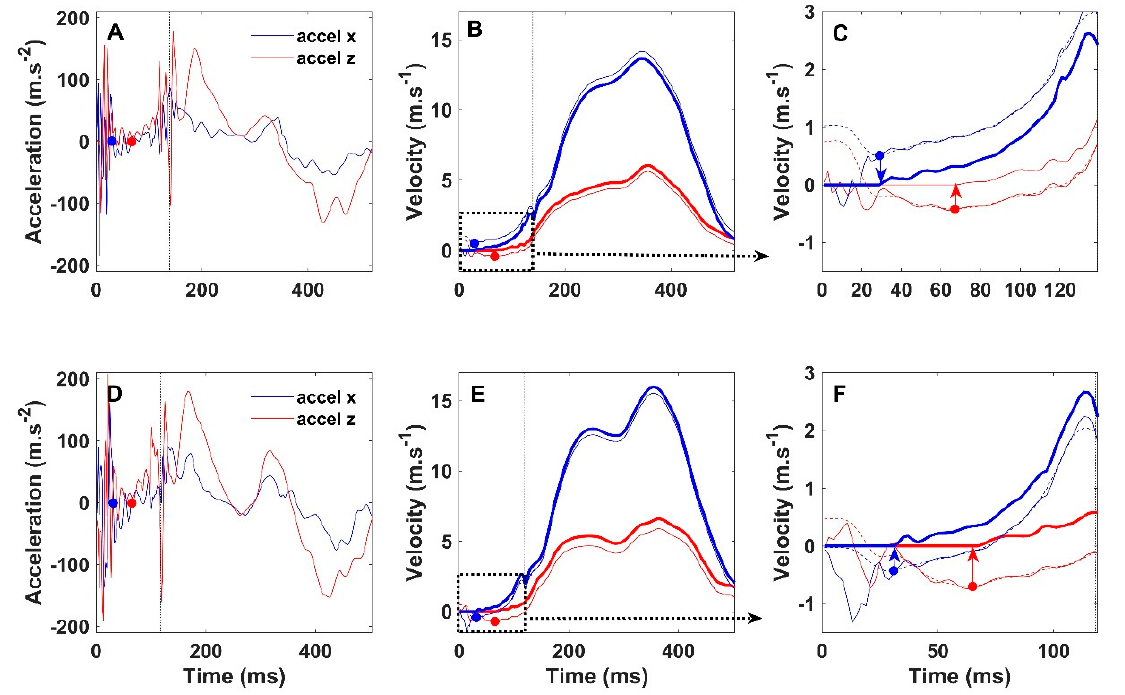
Figure 2. Acceleration ( A , D ) and velocity signals in the horizontal plane (x-z) of two strides within the same sprint (participant 2, right foot) are depicted. Top panels show stride number four: stride speed 7.2 m · s − 1 , SL 3.70 m from video, and 3.72 m from IMU. Bottom panels show stride number nine: stride speed 8.8 m · s − 1 , SL 4.41 m from video, and 4.36 m from IMU. Touch-down occurs at 0 s